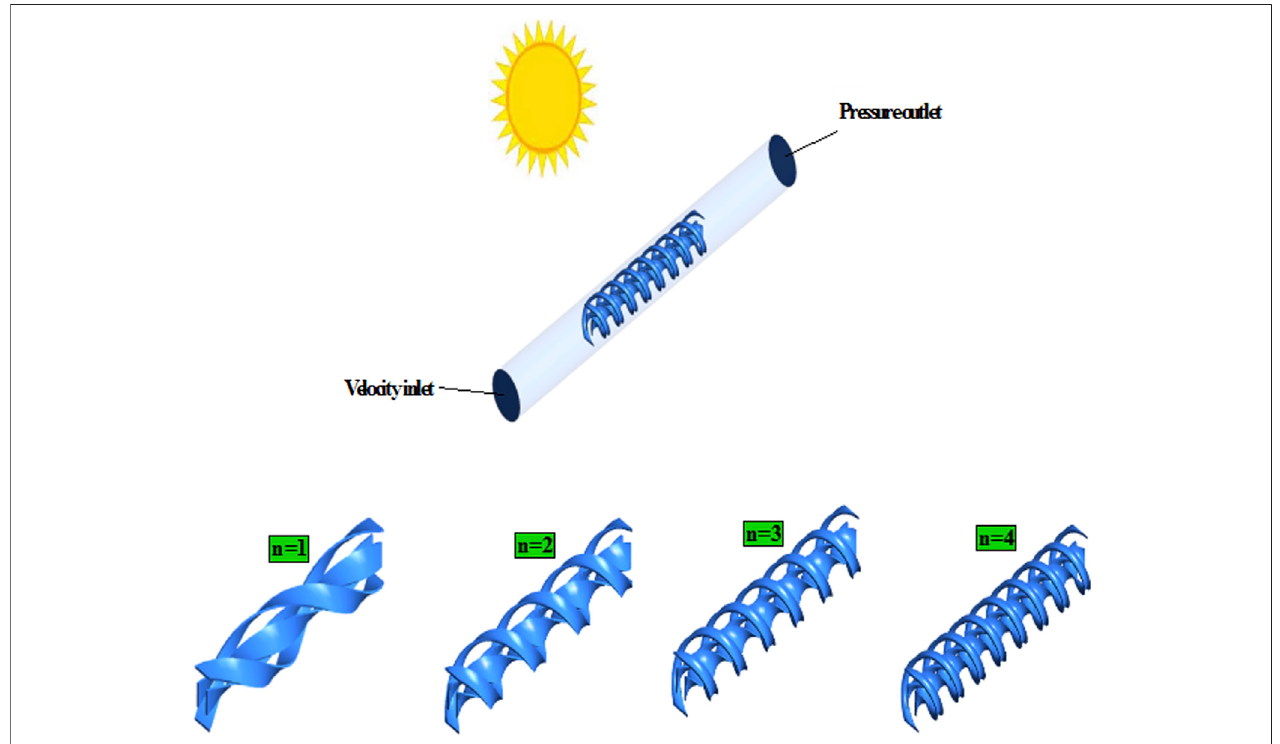
FIGURE 1 | The geometries of various solar collector combined turbulators.